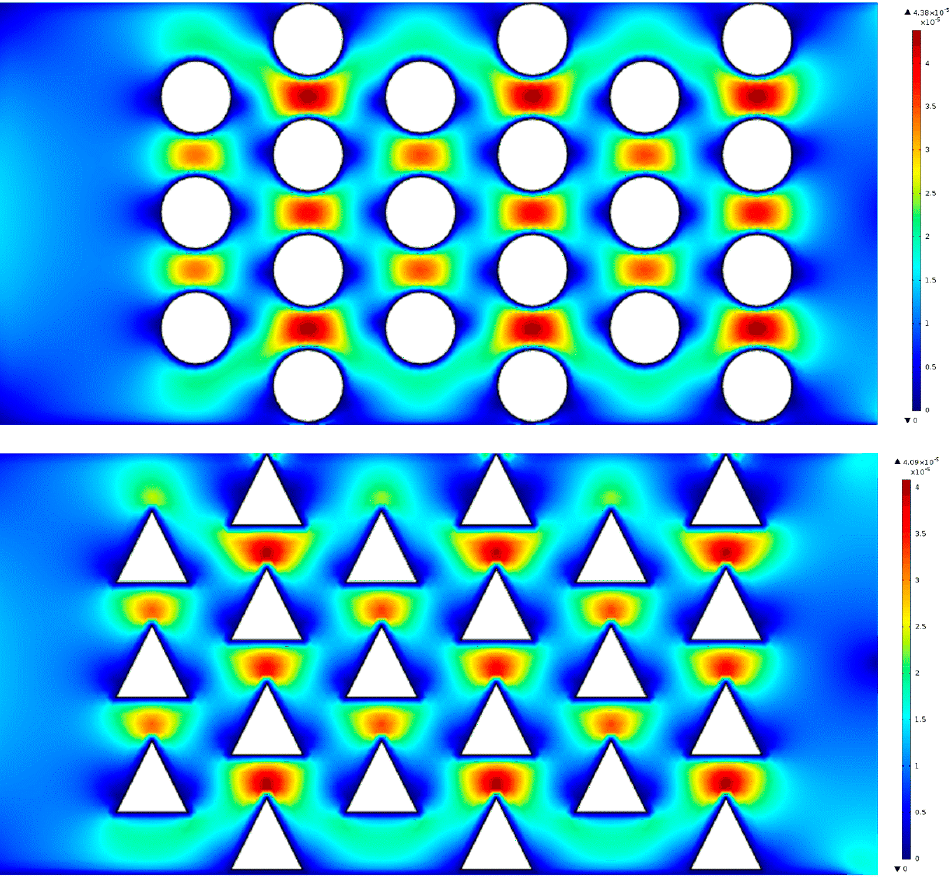
Figure 9. The flow velocity distribution within different shapes of the pillars. The row shift fraction is the same as ε = 0.1111. All velocity in the flow direction (x-axis) is represented by the maximum velocity values (m/s) observed in the DLD array, where red indicates a high flow rate region and dark blue a boundary with a no-slip condition, i.e., a zero-flow velocity region.